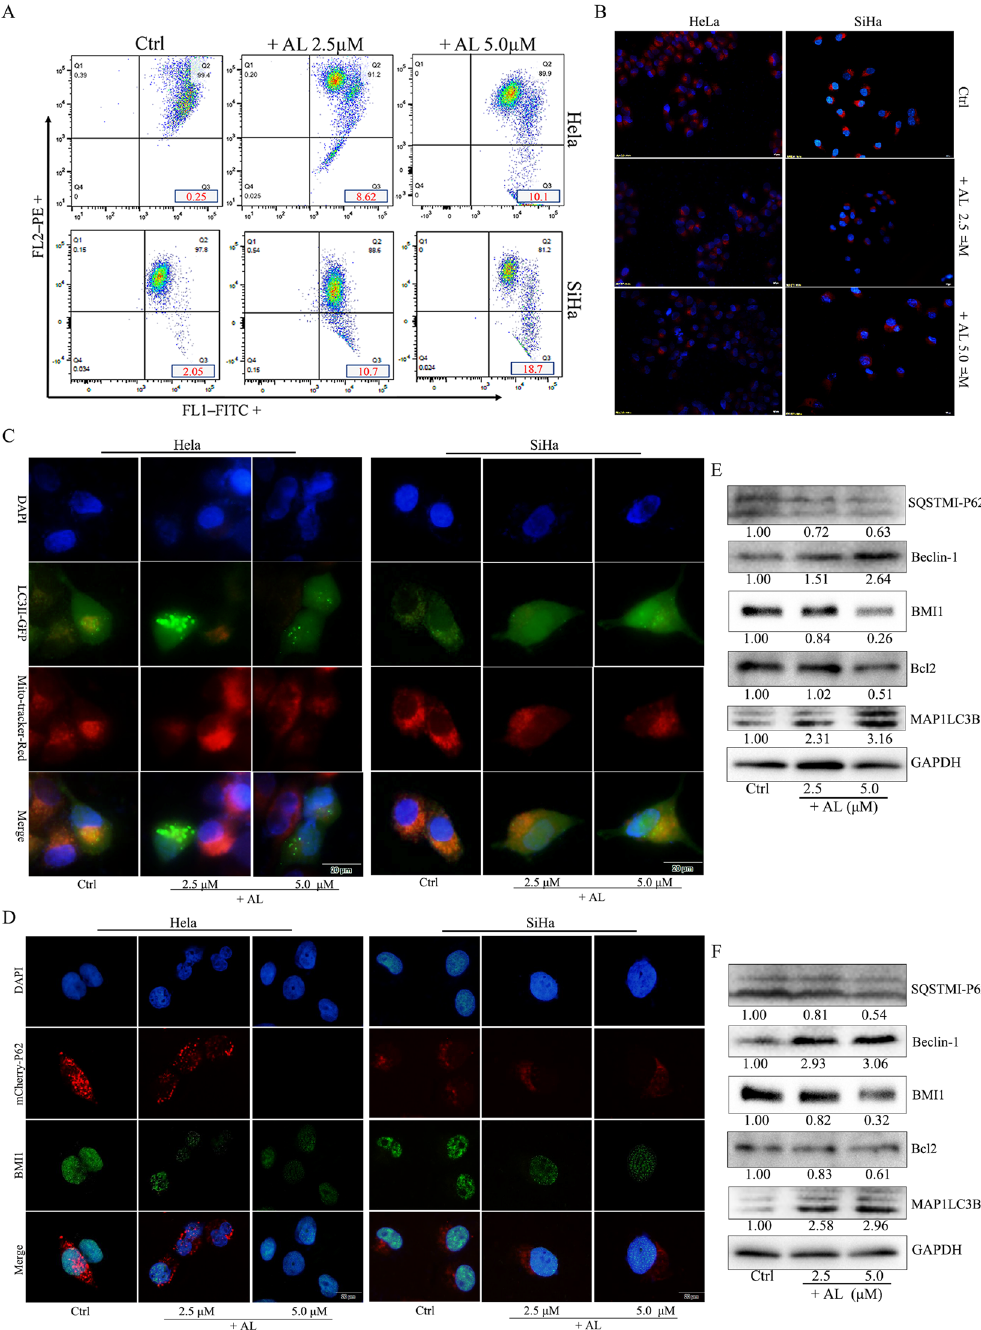
Figure 3. AL promoted mitochondrial damage and induced autophagy, while inhibiting BMI1 proteins in human cervical cancer cells. ( A ) HeLa and SiHa cells treated with AL (2.5, 5.0 µM) or vehicle for 24 h were stained with JC-1, and then measured using flow cytometry. ( B ) Mito-Tracker staining was used to visualize mitochondrial activity in HeLa and SiHa cells. Scale bar: 50 μm. ( C ) HeLa cells and SiHa cells were infected with Ad-GFP-LC3B for 24 h, then exposed to various concentrations of AL (0, 5, and 10 μM) for 24 h. On treatment, mitochondria labeled with Mito-Tracker Red CMXRos, and DAPI staining was used to visualize nuclei (blue). Scale bar: 20 μm. ( D ) HeLa and SiHa cells were infected with Ad-mcherry-P62 for 24 h, then exposed to various concentrations of AL (0, 5, and 10 μM) for 24 h. After the treatment, BMI1 was determined using immunocytochemistry and DAPI staining was used to visualize nuclei (blue). Scale bar: 20 μm. ( E ) The protein level of Beclin-1, BMI1, Bcl-2, LC3IIB, and P62 were detected using western blot in HeLa cells. ( F ) The protein level of Beclin-1, BMI1, Bcl-2, LC3IIB, and P62 were detected using western blot in SiHa cells. Here cropped blots were displayed and all full- length blots are included in the Supplementary Information